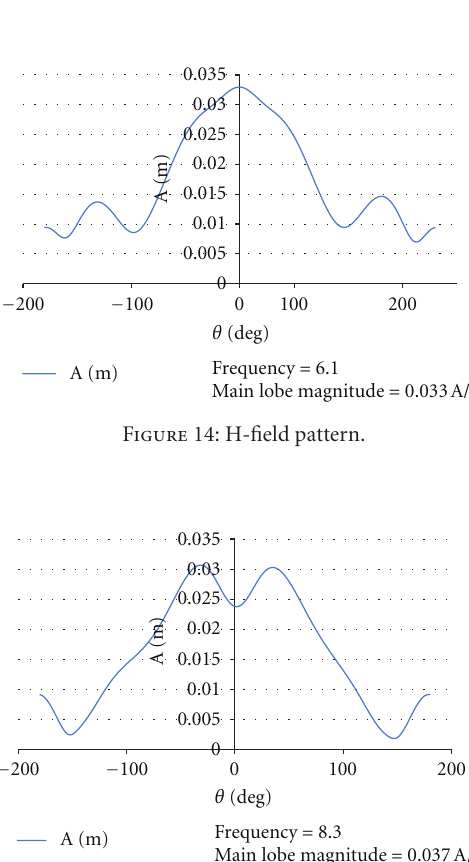
Figure 15: H-field